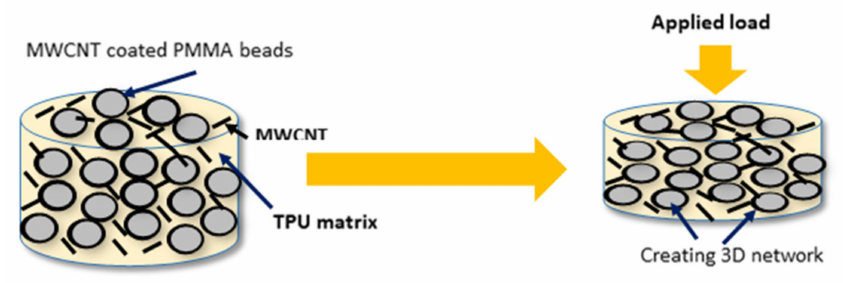
Figure 10 . Schematic diagram of the formation of three-dimensional conductive